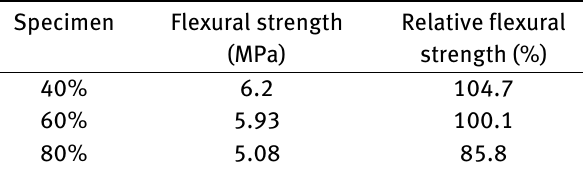
Table 20: Flexural strength of geopolymer mortar Specimen